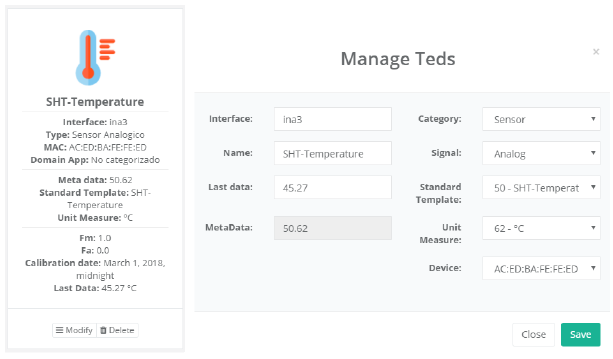
Figure 17. VTED management